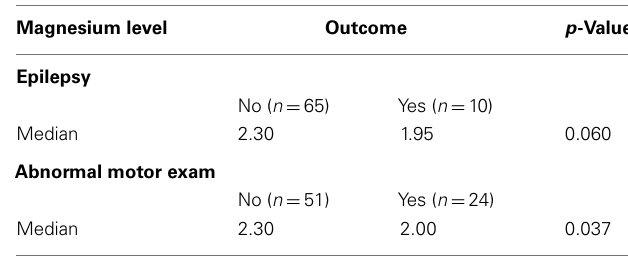
Table 3 | Characteristics of serum magnesium testing . Table 4 |Wilcoxon rank-sum tests for epilepsy and for abnormal motor exam